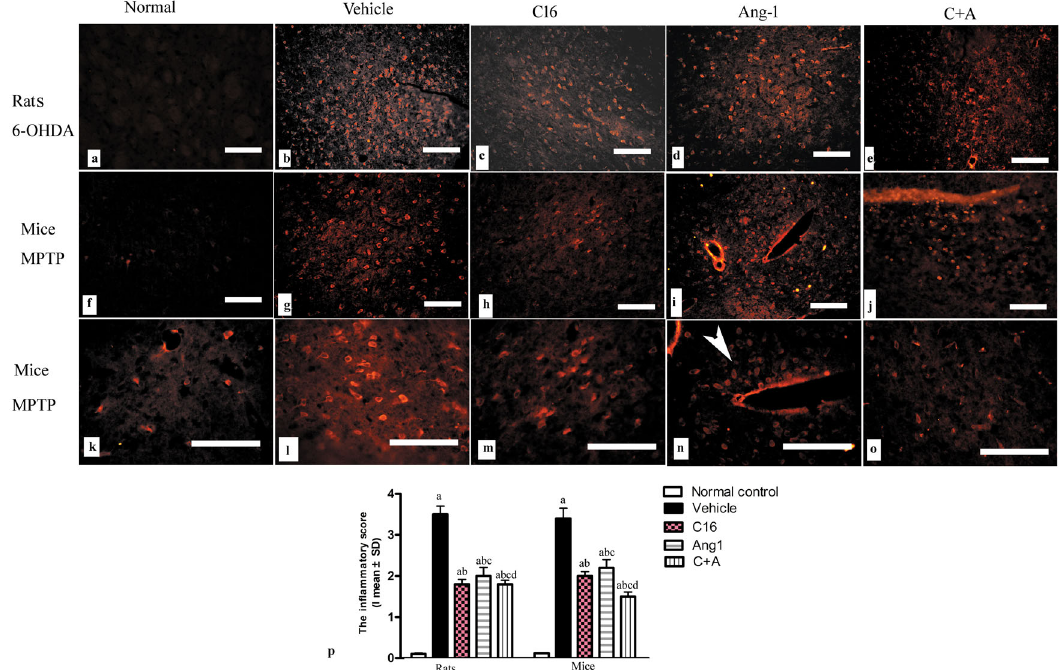
Fig. 4 C16 in combination with Ang-1 treatment attenuated in fl ammatory cell in fi ltration. The immunostaining of CD3 revealed in fl ammatory cell in fi ltration in the vehicle-treated model group ( b , g , l ), but not in normal controls ( a , f , k ). Treatment with C16 ( c , h , m ), Ang-1 ( d , i , n ), or both ( e , i , o ) attenuated in fl ammation in PD animals. C16 alone or in combination with Ang-1 showed better effects than Ang-1 alone. The white arrow in N showed perivascular cuf fi ng of CD3 + in fl ammatory cells. The in fl ammatory scores ( p ) were calculated. 0, no in fl ammation; 1, cellular in fi ltrates only detected around meninges and blood vessels; 2, mild in fi ltrates detected in parenchymal tissues (1 – 10 in fl ammatory cells per slide); 3, moderate in fi ltrates observed in parenchymal tissues (11 – 100 in fl ammatory cells per slide); and 4, severe in fi ltrates in parenchymal tissues (>100 in fl ammatory cells per slide). a p < 0.05 versus the normal control group; b p < 0.05 versus the vehicle group; c p < 0.05 versus the C16-treated group; d p < 0.05 versus the Ang-1-treated group. Scale bar = 100 μ m. C16, peptide